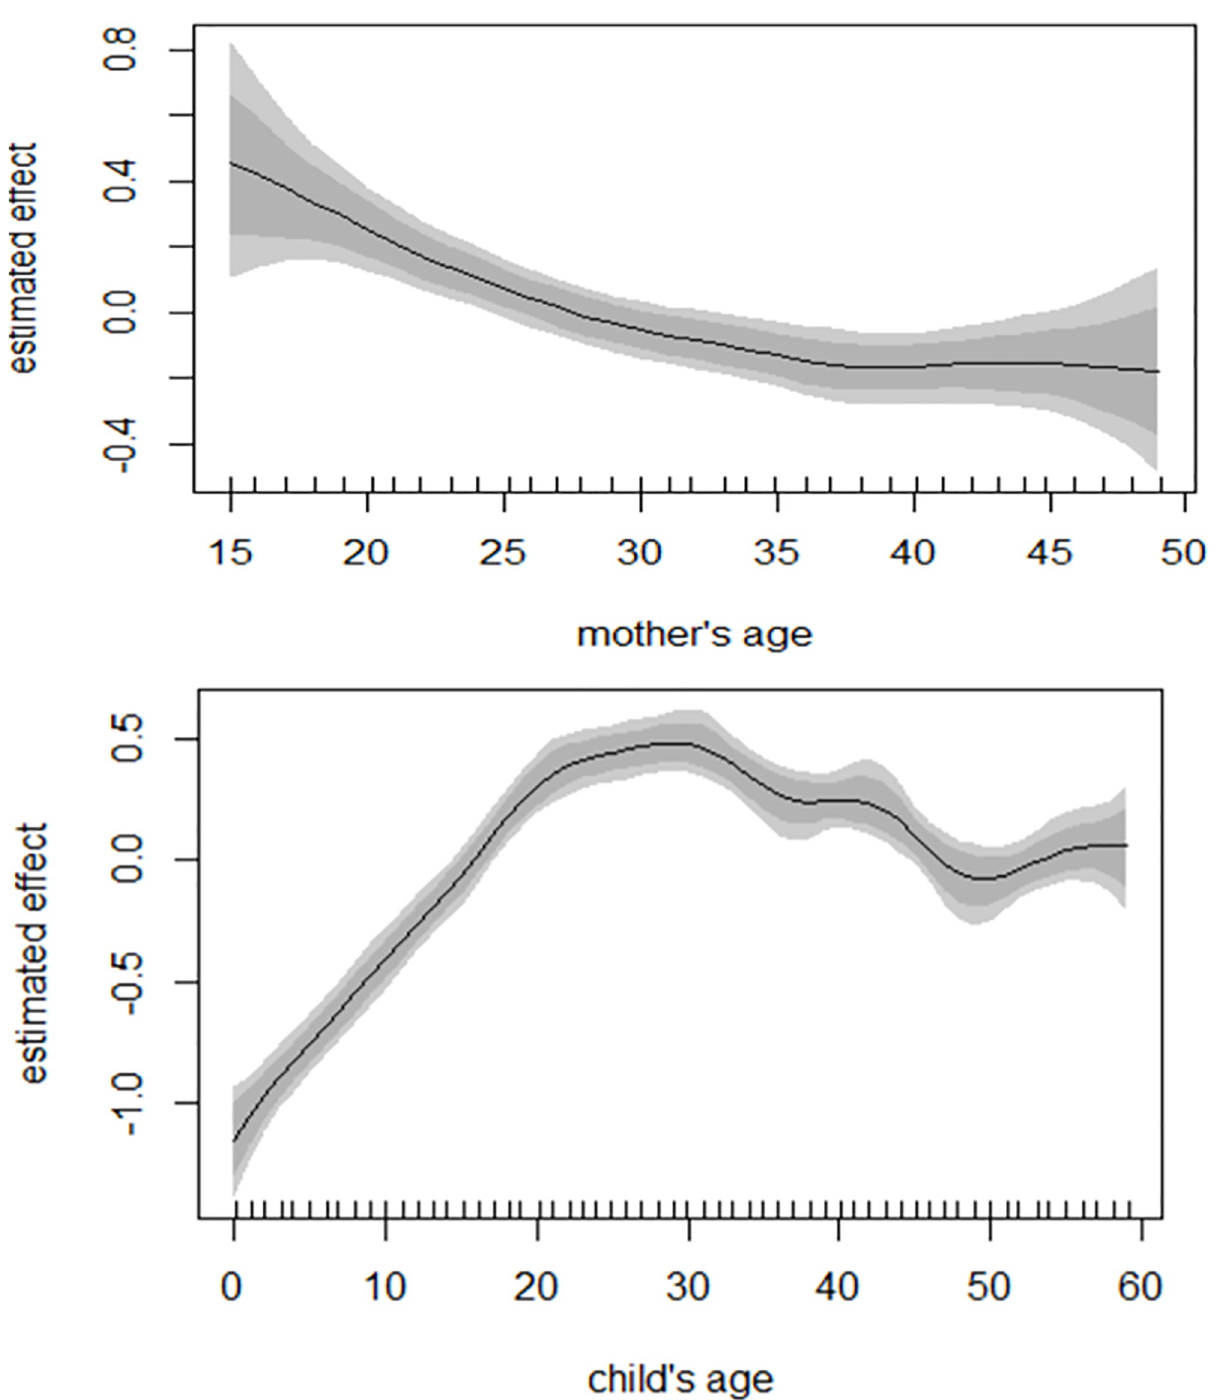
Fig 3. Estimated non-linear effects of mother’s age (Top panel) and child’s age (Bottom panel). Posterior means and their associated 95% credible intervals are shown.